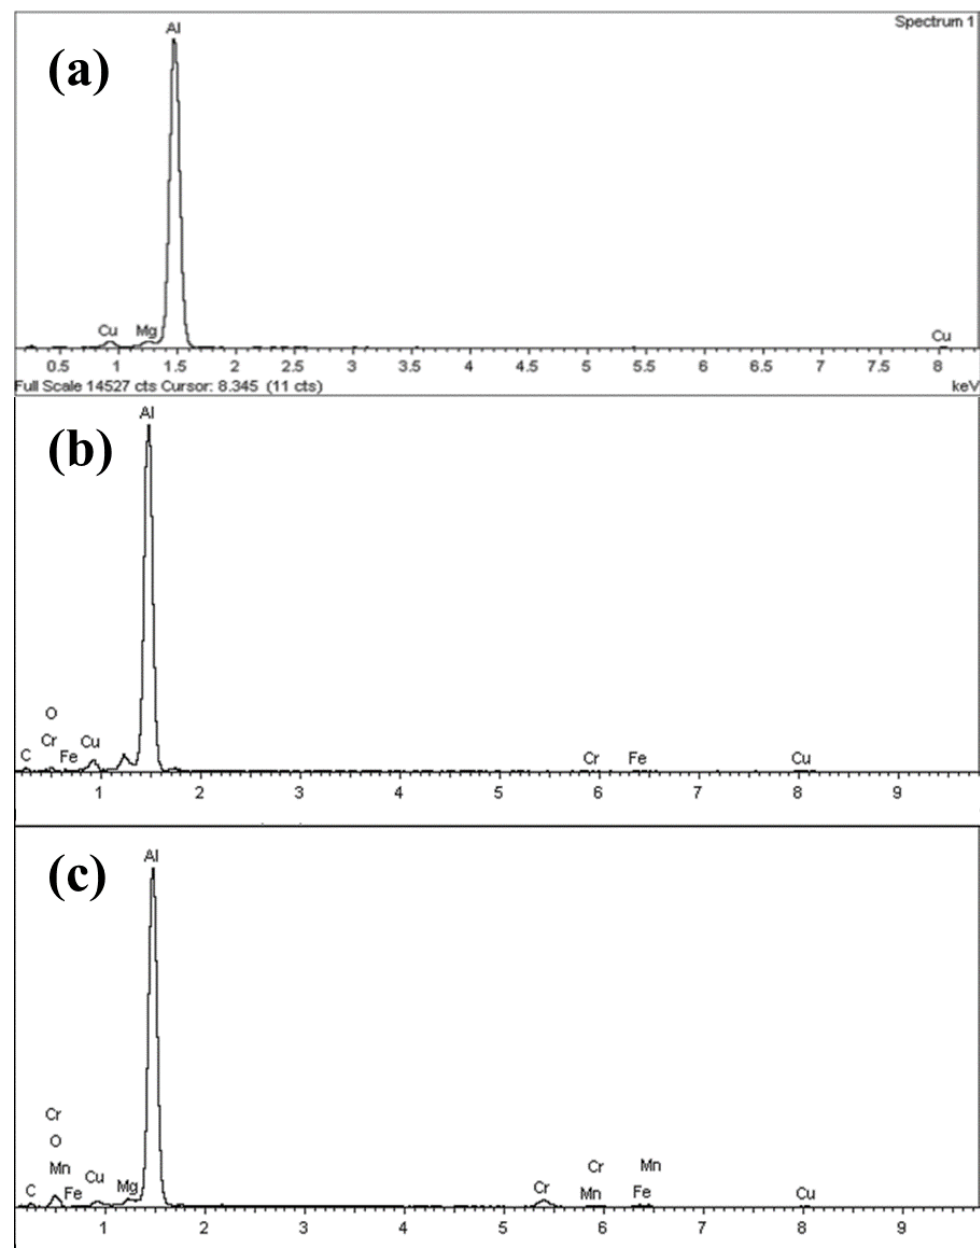
Figure 13. ( a ) Spectrum of unworn aluminum samples before the test. EDX spectrum of worn surfaces of aluminum pin samples for neat oil after the test at ( b ) 10 N and ( c ) 20 N.